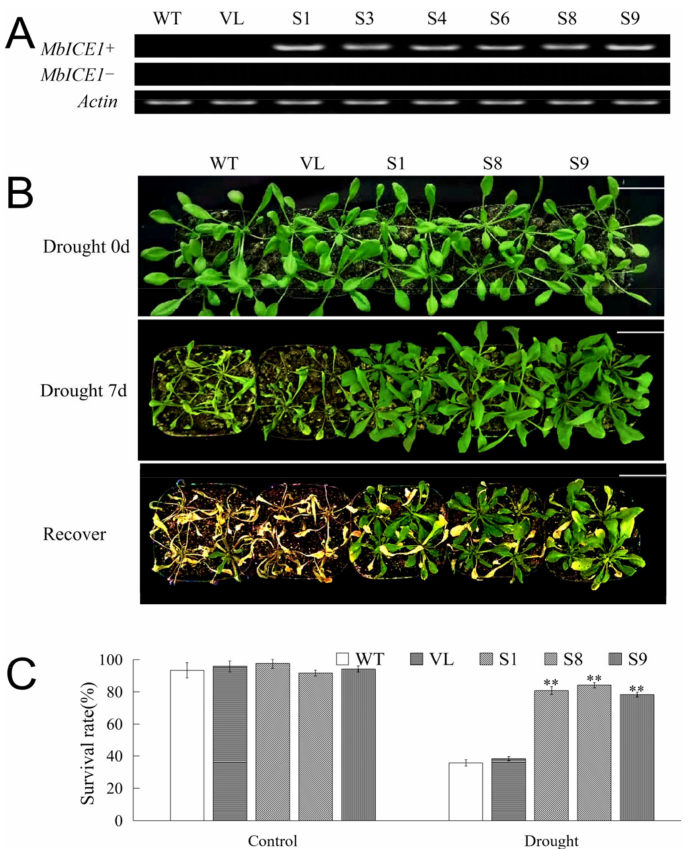
Figure 5. Overexpression of MbICE1 improves drought resistance of plants. ( A ) PCR was used to verify the expression of MbICE1 in WT, VL, and transgenic Arabidopsis . The actin gene (AB638619.1) was selected as the control group. ( B ) Phenotypes of WT, VL (vector line), and overexpression- MbICE1 (S1, S8, and S9) under control, drought, and recovery growth. The white scale bar represents 3 cm. ( C ) Survival rates of WT and overexpression- MbICE1 lines after Drought 0 d and Drought 7 d. The value is the average of three repeats. The standard deviation is represented by the error bar. The asterisk indicates the difference compared to WT (** p ≤